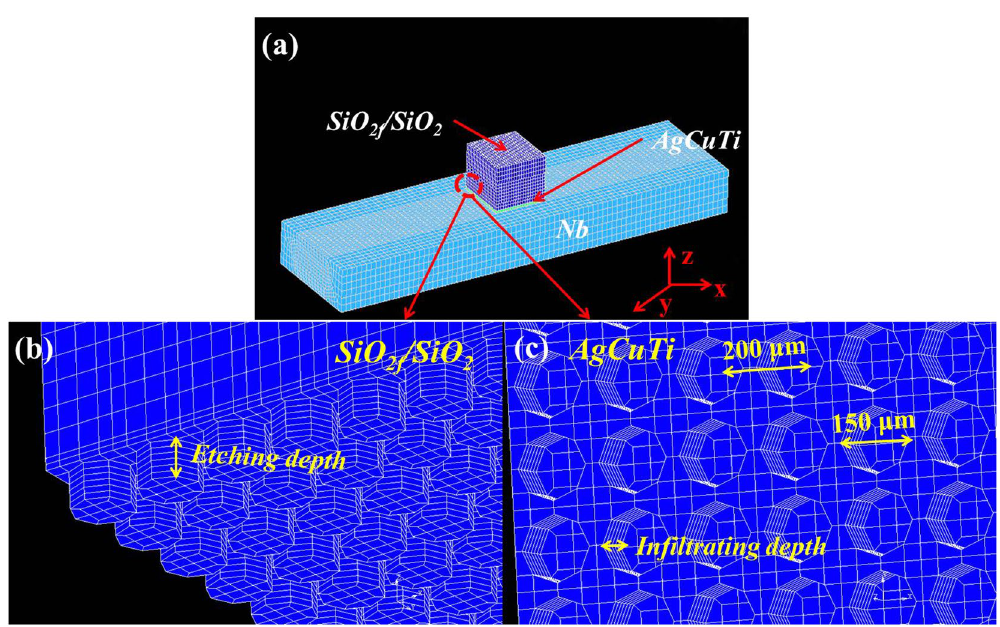
Figure 4. Mesh of finite elements for ( a ) the brazed joint, ( b ) magnification of the E-SiO 2f /SiO 2 , ( c ) magnification of AgCuTi brazing